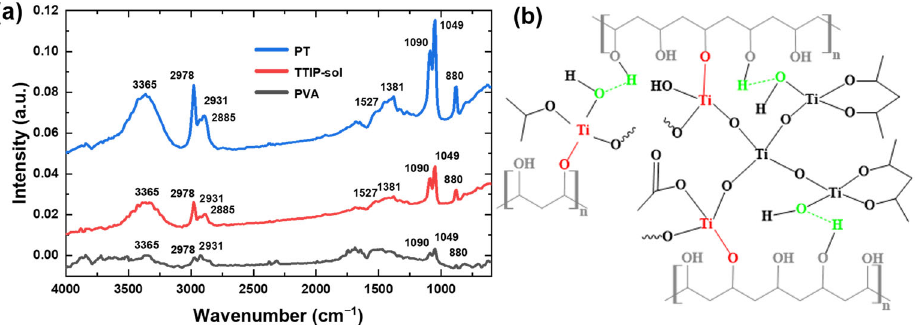
Figure 1. ( a ) FT ‐ IR spectra of PVA, TTIP ‐ sol, and PT. ( b ) Schematic structure of PT. Both mononu ‐ Figure 1. ( a ) FT-IR spectra of PVA, TTIP-sol, and PT. ( b ) Schematic structure of PT. Both mononuclear clear titanium (left) and Ti ‐ O ‐ Ti meshes (right) are represented, with hydrogen bonds (green) and titanium (left) and Ti-O-Ti meshes (right) are represented, with hydrogen bonds (green) and covalent covalent bonds (red) indicating a good, cross ‐ linked structure. bonds (red) indicating a good, cross-linked